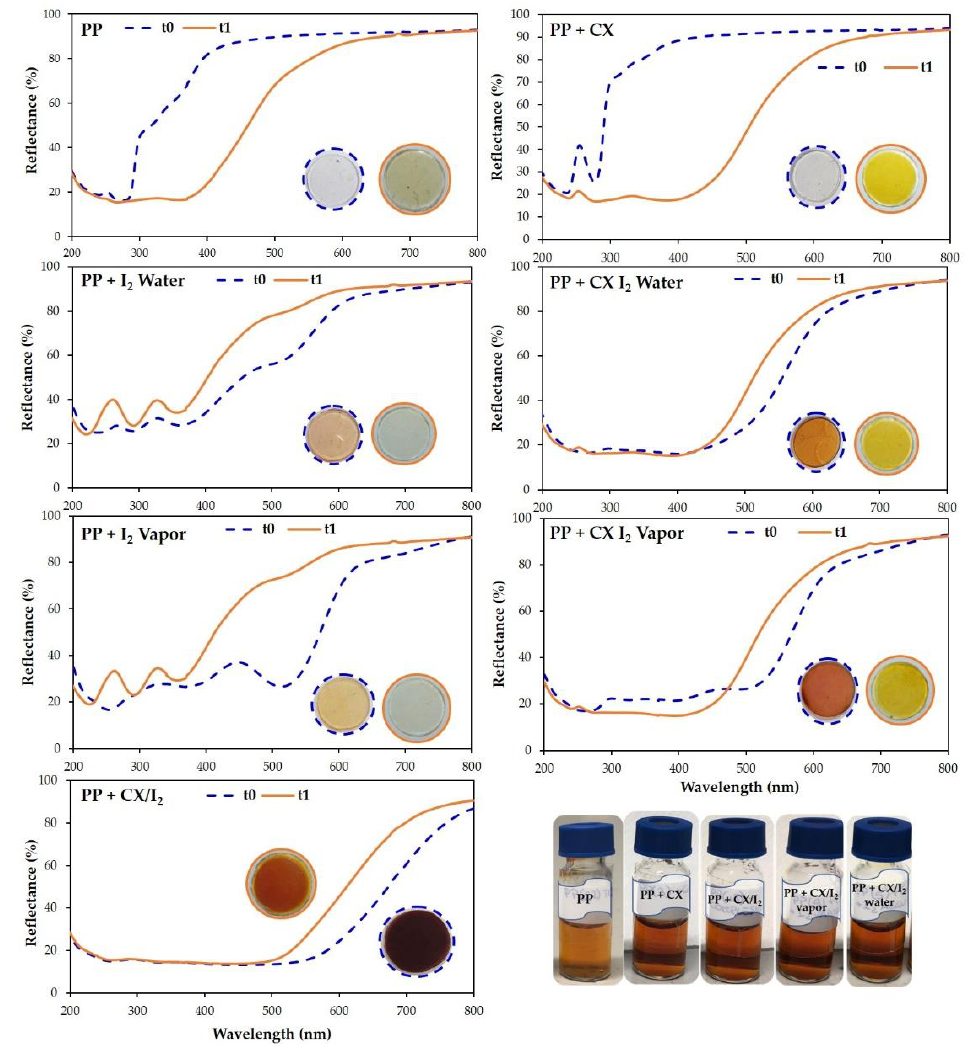
Figure 13. Reflectance (%) spectra and photographic documentation of PP circular film samples unmodified and loaded with iodine or CX/iodine complex at t = 0 (dashed blue line) and after 7 days placed on the cup of a 0.3% PVP-I water solution (solid orange line) at 40 °C.